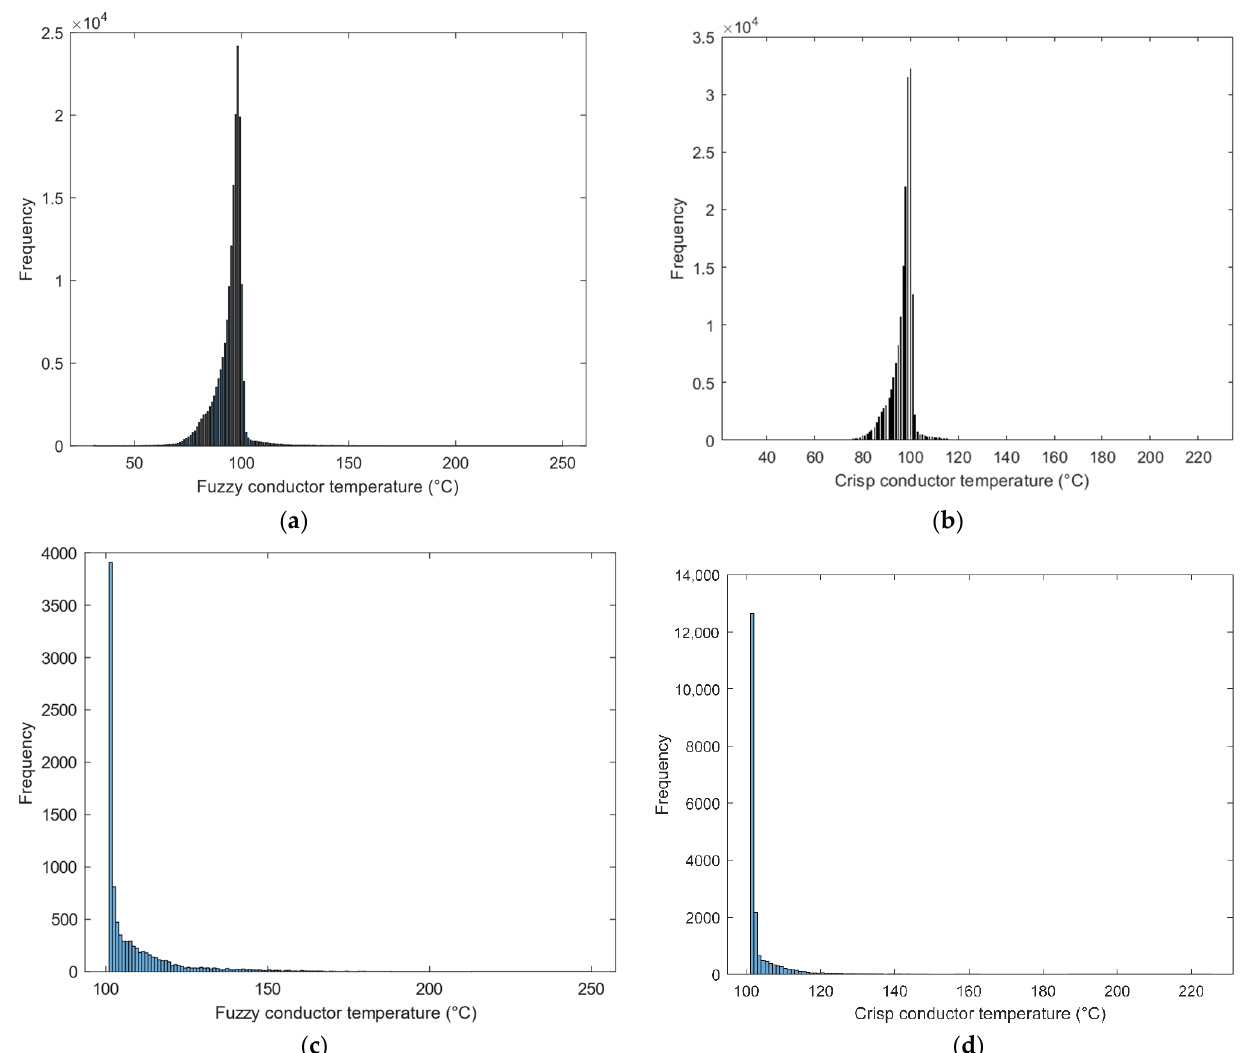
Figure 10. ( a ) Temperature frequency histogram for fuzzy rating over a twenty-year period; ( b ) temperature frequency histogram for crisp rating over a twenty-year period; ( c ) temperature frequency histogram above 100 °C for fuzzy rating over a twenty-year period; ( d ) temperature frequency histogram above 100 °C for crisp rating over a twenty-year period. Table 5. Exposure time according to the frequency of conductor temperatures for fuzzy dynamic rating over a twenty-year period.